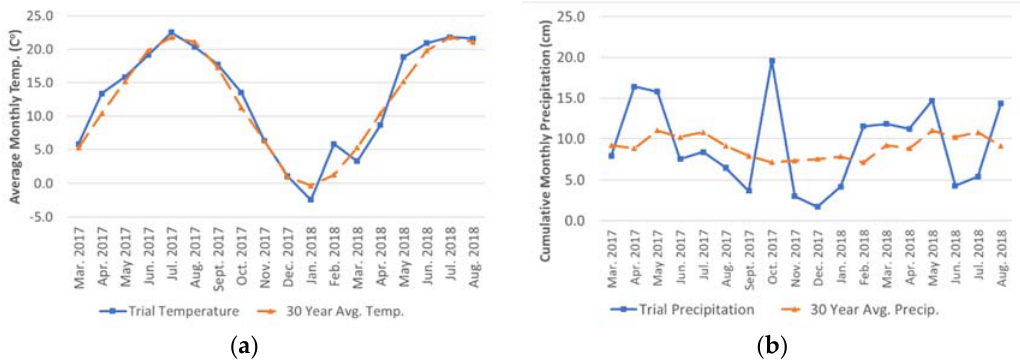
Figure 1. Monthly air temperature ( a ) and cumulative monthly precipitation ( b ) as measured by a local National Oceanic and Atmospheric Administration weather station (March 2017 to August 2018) vs. the 30-year mean for Blacksburg, VA, USA.